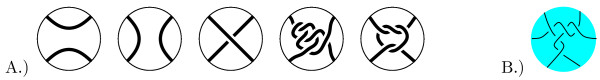
A.) Some 2-string tangles. B.) a 3-string tangle.